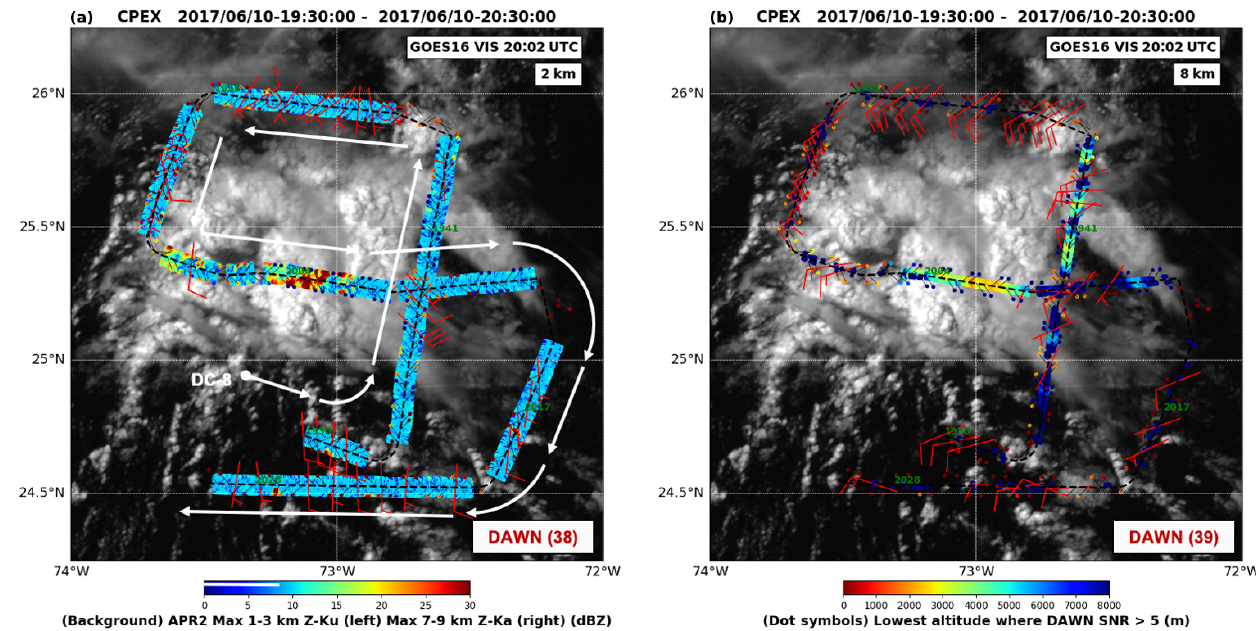
Figure 10. DC-8 flight line during segment 2 (19:30–20:30UTC) on 10 June 2017. The GOES-16 visible imagery at 20:00UTC is shown in the background grayscale. DAWN winds at each level are indicated with the red barb symbols. (a) 2km level. The background color represents the average APR-2 Ku-band reflectivity between 1 and 3km of height. (b) Same as panel (a) , but for an 8km height. The background color represents the APR-2 average Ka-band reflectivity between 7 and 9km. In both panels, the symbol (dot) colors indicate the lowest level at which the DAWN SNR is > 5dB (lower panel color scale) according to the color scale in panel (b) . Periods of missing APR-2 data indicate no data.